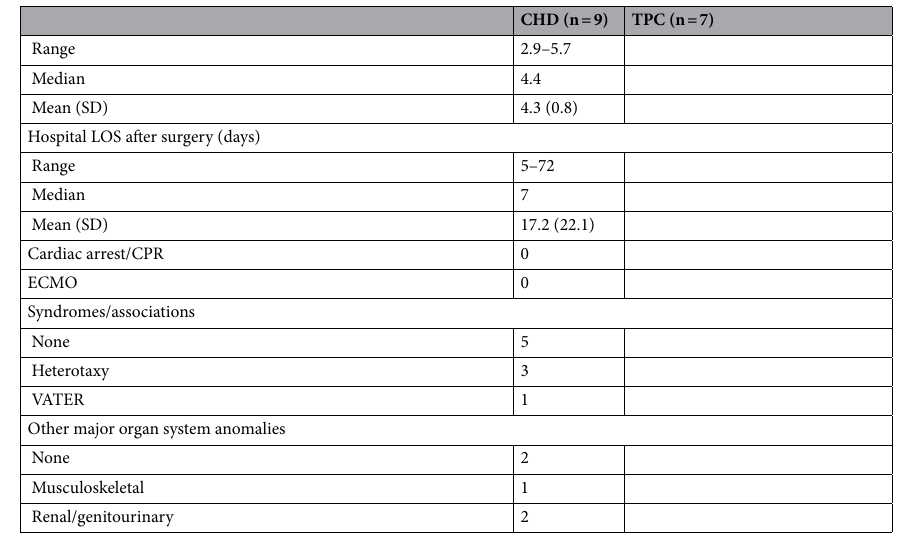
Table 1. Demographic and clinical variables of CHD and TPC groups. Note: LOS = Length of stay.